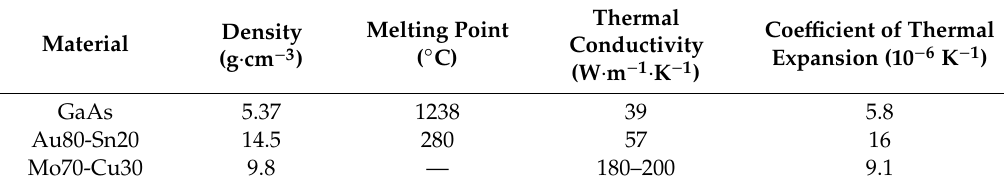
Table 1. Physical characteristics of materials used in this